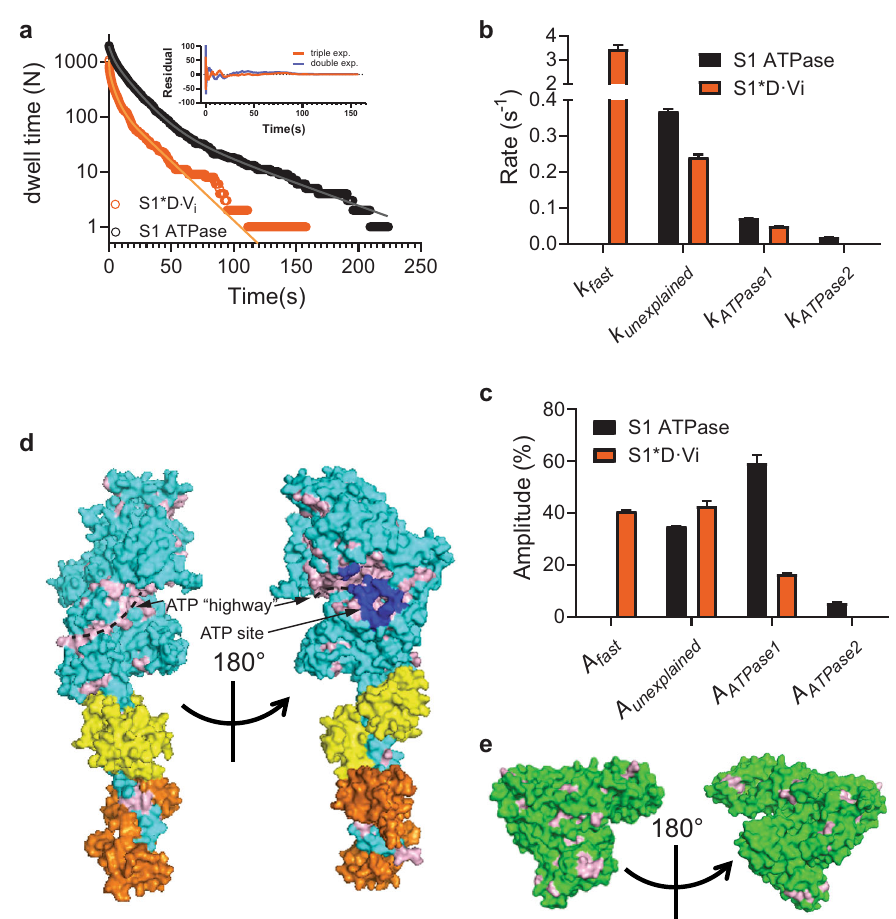
Fig. 5 Origin of “ unexplained ” (0.2 – 0.5 s − 1 ) exponential phase. a Cumulative frequency distributions of Alexa-nucleotide dwell time events on myosin subfragment 1 (S1) surface hotspots (simple deposition of S1, Fig. 1a, i). Data either with ( N dwell = 1964 from 127 S1 molecules in 15 min) or without ( N dwell